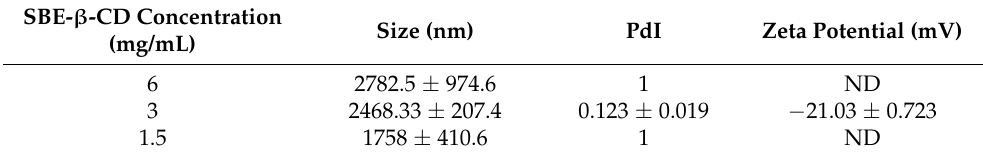
Table 1. Average size, PdI and zeta potential of SBE- β -CD/quercetin inclusion complexes for various ratios. The values are representative of the media obtained in three independent assays (n = 3). Abbreviations: ND = Not